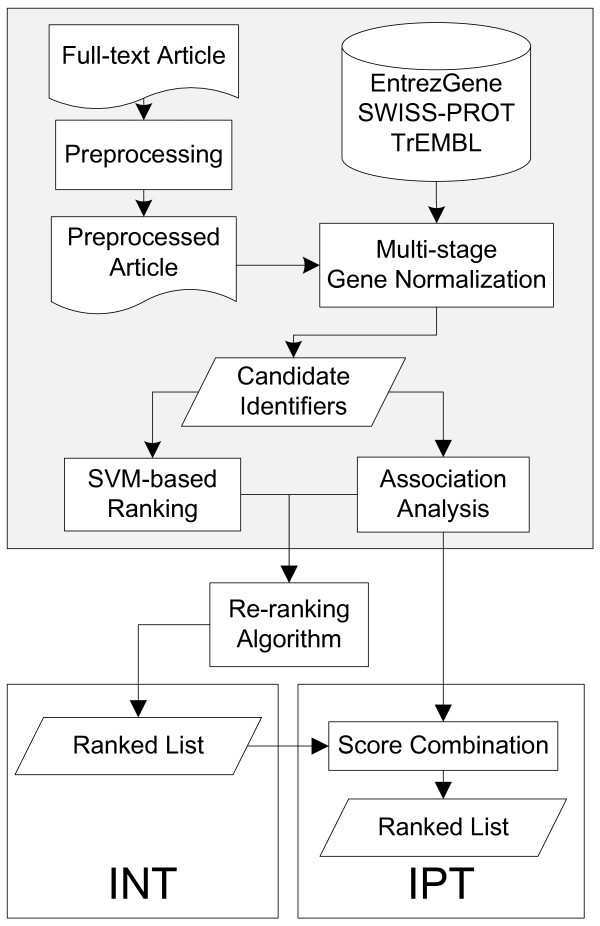
System workflow.